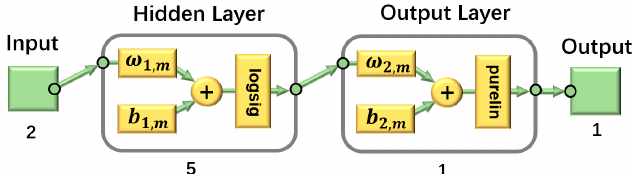
Figure 8. The BPNN for the measurement model of SSM, where ω 1, m and ω 2, m are the weights, b 1, m and b 2, m are the bias values. The input vector x k whose dimension is 2 contains the joint angle and angular velocity, and the output vector y k whose dimension is 1 contains the interactive force, and 2, 5 and 1 are the numbers of the neurons.